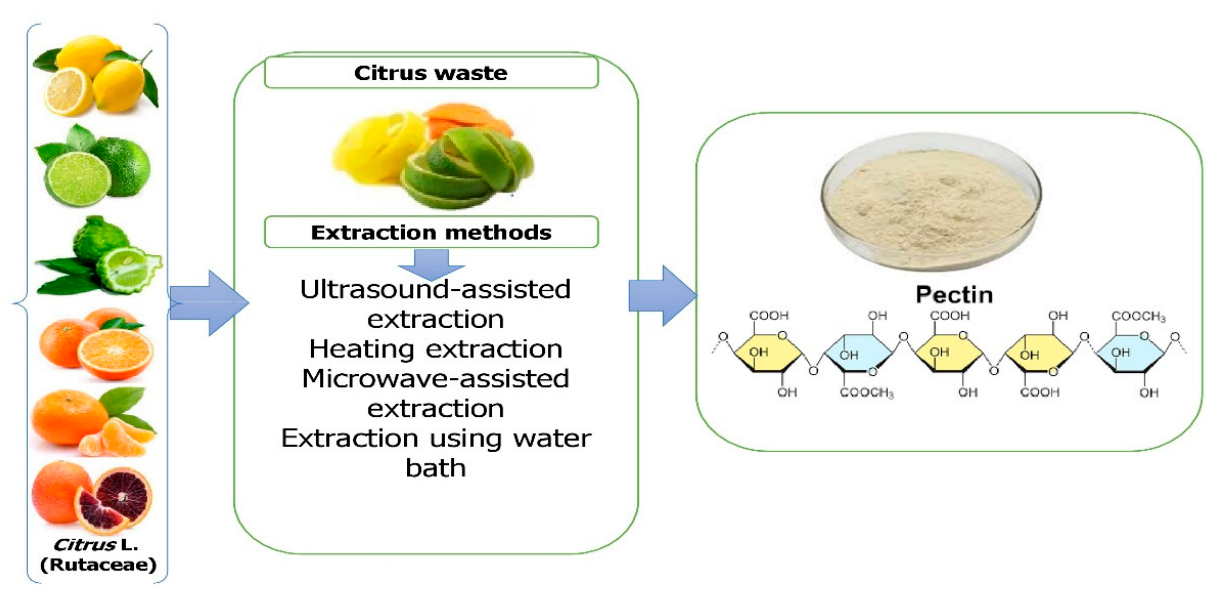
Figure 3. Extraction of pectin from Citrus L. waste.